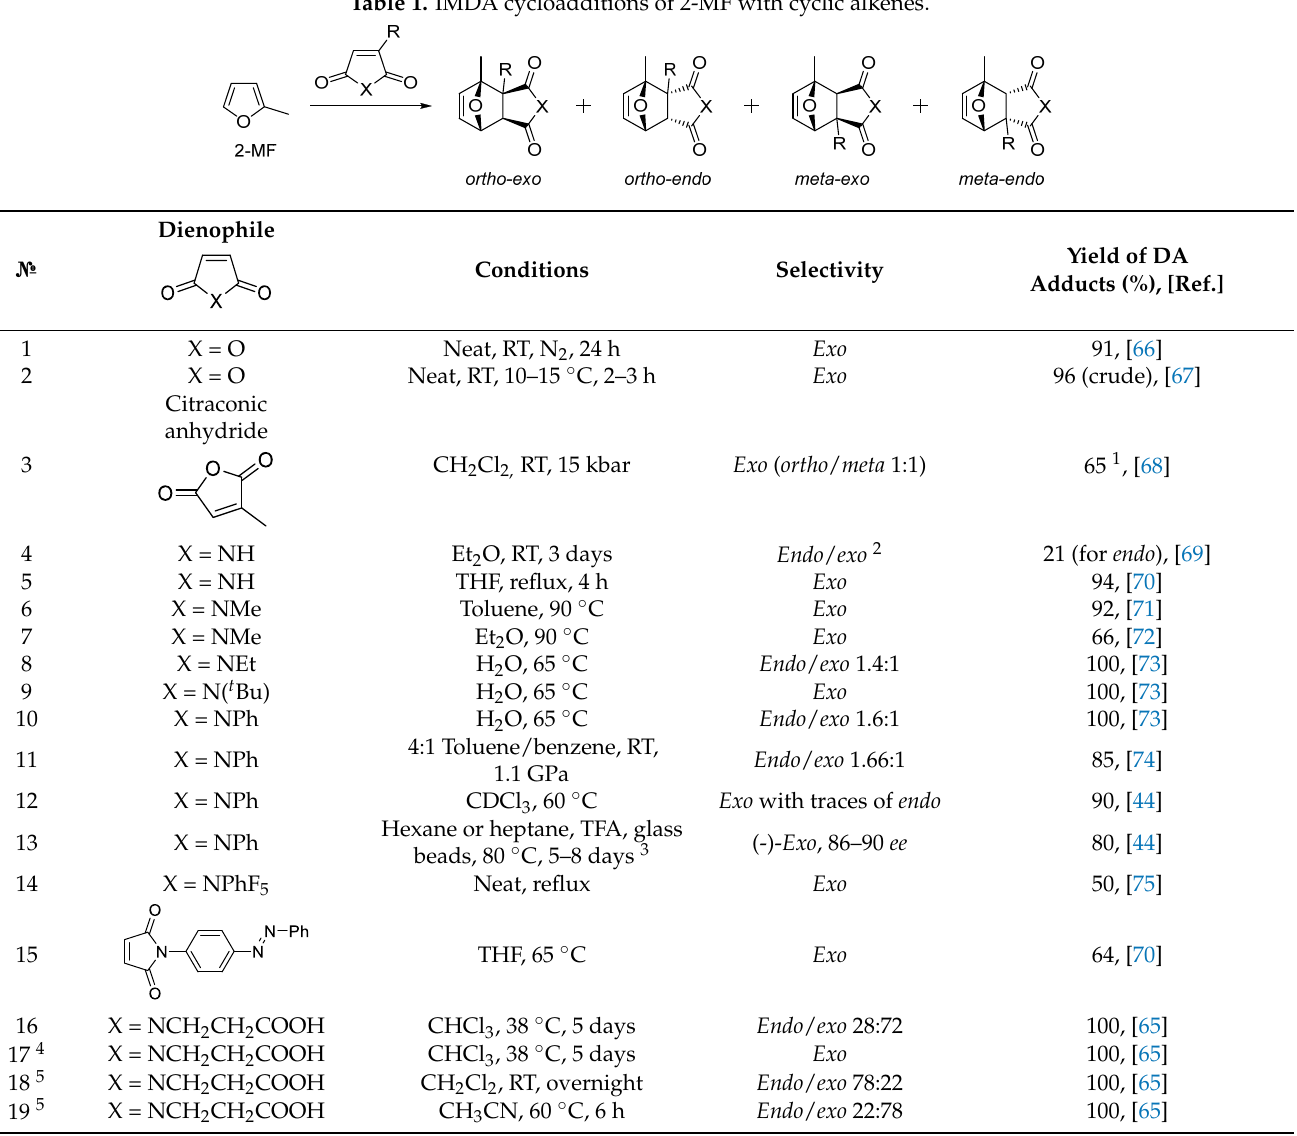
Table 1. IMDA cycloadditions of 2-MF with cyclic alkenes.